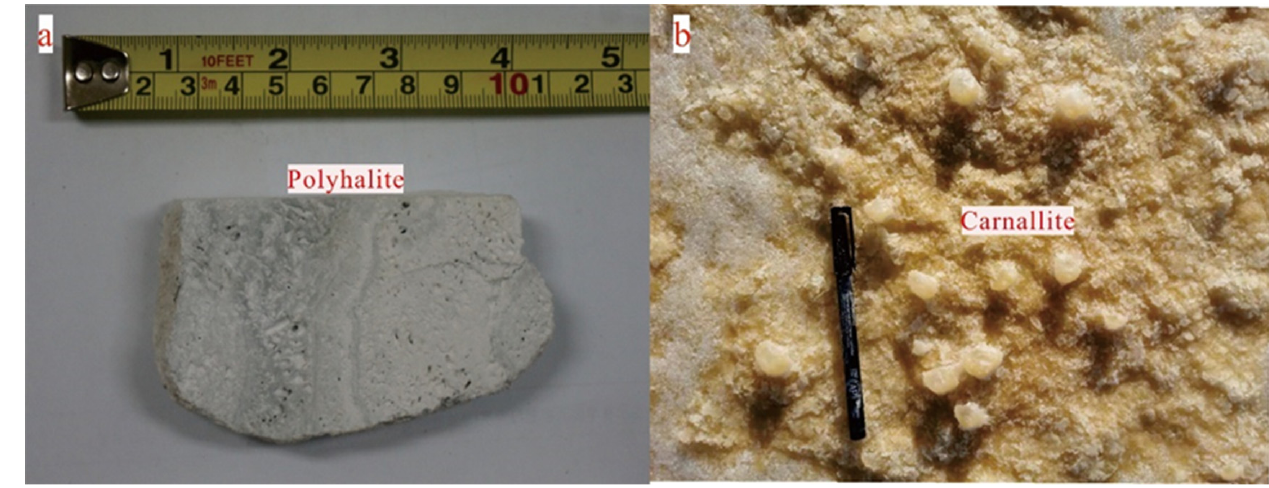
Figure 3. Pictures of polyhalite and carnallite; ( a ) polyhalite, sampled in the north of the Luobei Depression; ( b ) carnallite, sampled in the east part of the Tenglong Platform. Table 1. Results of X-ray Diffraction of